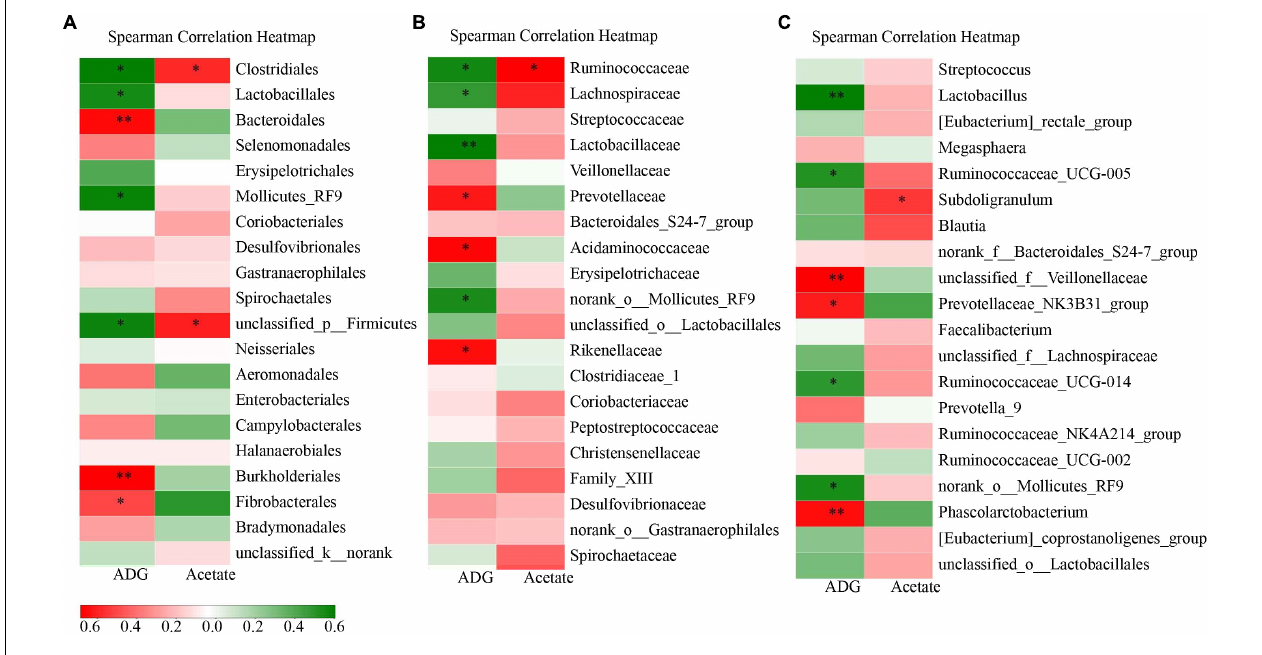
FIGURE 3 | Correlation analysis between the varied ADG and fecal acetate and corresponding intestinal flora at different levels on d 28. (A) is the order level. (B) is the family level. (C) is the genus level. Star in red color bar means that there is a significant positive correlation. Star in green bar means that there is a significant negative